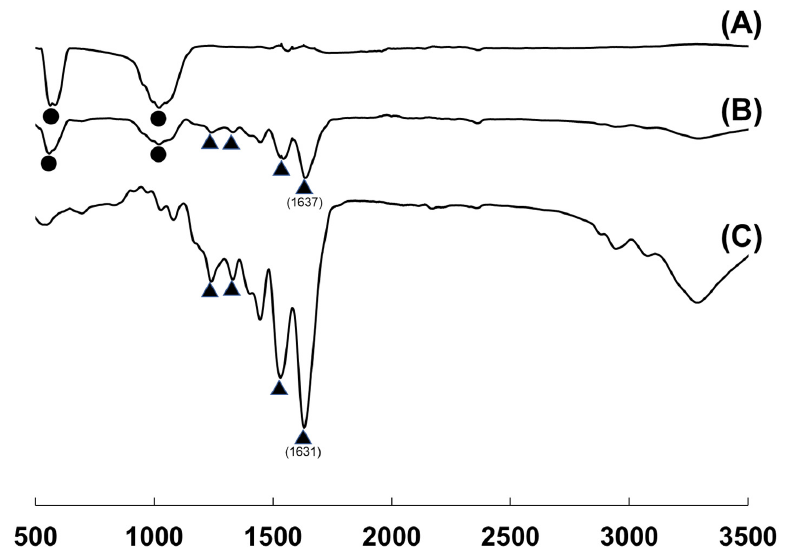
Figure 6. Results of FTIR. ( A ) α -TCP; ( B ) α -TCP/GS; and ( C ) GS. α -TCP/GS, composite gelatin sponge; GS, gelatin scaffolds; and α -TCP, alfa-tricalcium phosphate. The circles represent the char- acteristic peaks of α -TCP, whereas the triangles represent those of gelatin.